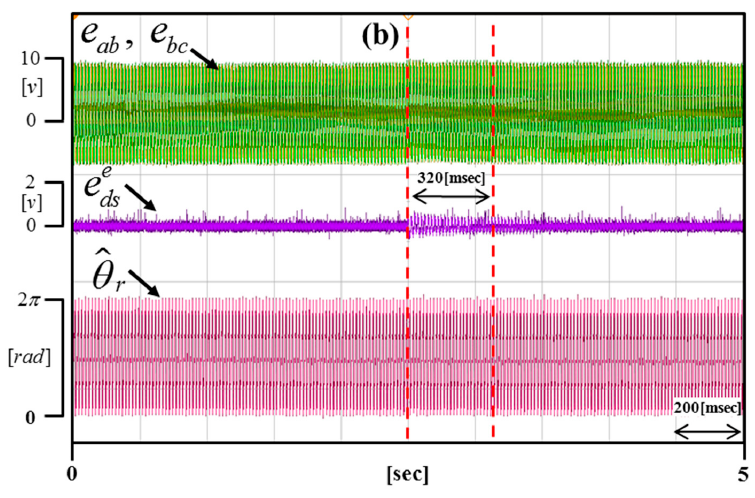
Figure 18. Enlargement of the portion in Figure 16b.